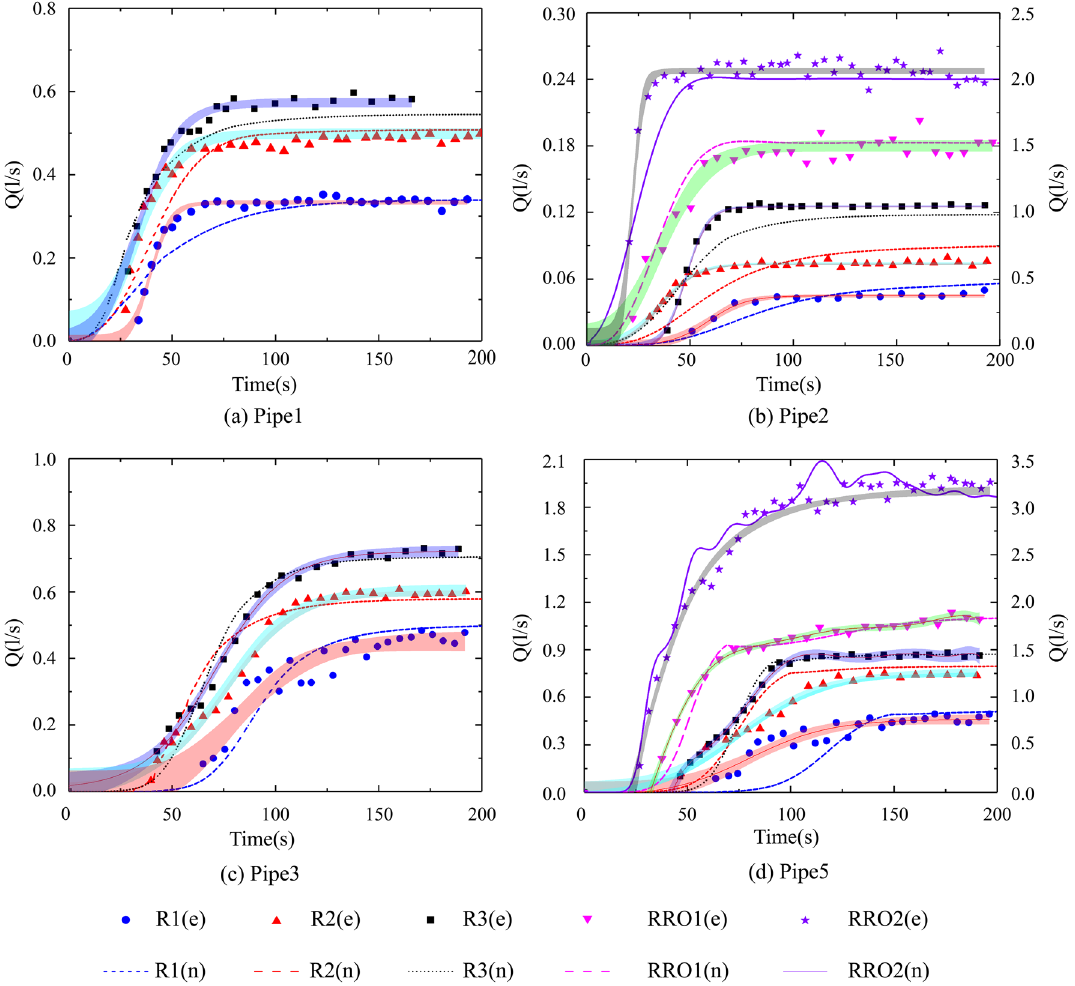
Figure 5. Modeled and measured discharges in the pipe system. The points and lines represent the measured values (e) and the numerical simulation values (n), respectively. There were three rainfall events (R1, R2, R3) and two rainfall-runoff events (RRO1, RRO2). In Fig. b and d, the secondary axis illustrates the discharges in the rainfall-runoff